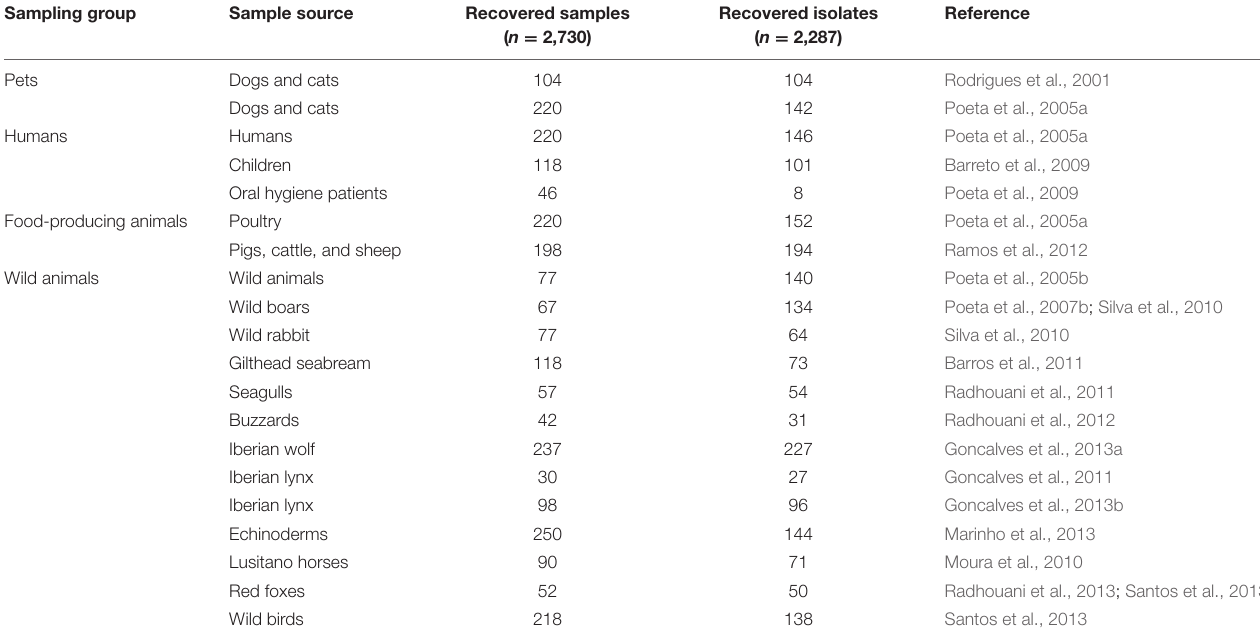
TABLE 2 | Description of all sources of Enterococcus spp. isolates analyzed in a decade of AMR surveillance in Portugal by the UTAD Functional Genomics and Proteomics Unit. Sampling